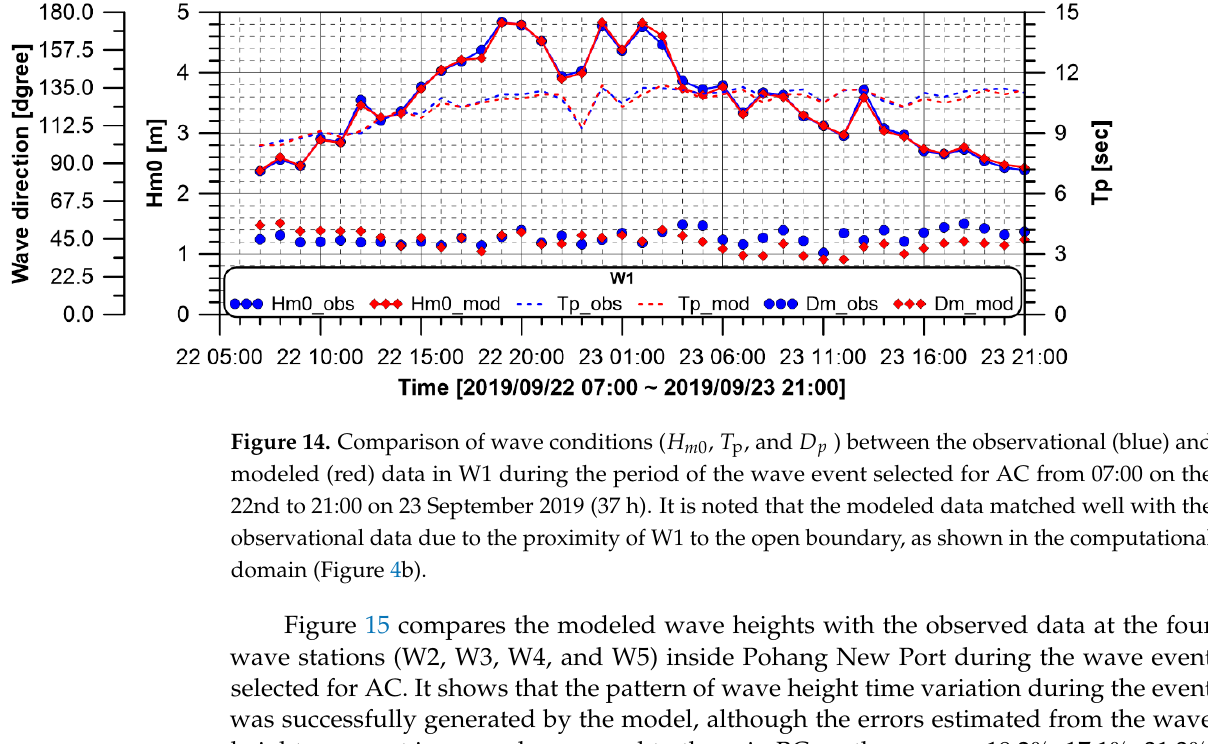
19 of 31 Figure 13. Comparison of wave height ( 𝐻 (cid:3040)(cid:2868) ) between the observational (blue) and modeled (red) data at the four wave stations inside Pohang New Port (W2, W3, W4, and W5) during the period of the wave event selected for BC from 05:30 on the 26 to 21:30 on 27 April 2009. Reasonable agreements are observed between the observational and modeled data, supporting the model validation. A similar comparison between the modeled and observational data was carried out for the selected event case in AC. In Figure 14, the observed and modeled wave conditions in W1 are plotted for the period of the wave event selected for AC, from 07:00 on the 22 to 21:00 on 23 September 2019. Similar to the event case in BC, the wave conditions in W1 were nicely matched between the model and observation due to the proximity of the lo- cation of W1 to the open boundary. It was shown that the wave height increased to be- come the maximum ( 𝐻 (cid:3040)(cid:2868) ~4 .8 m) at 19:00 on 22 September 2019 and then gradually de- creased to ~2.5 m at 21:00 on the 23rd in W1. The wave period generally increased from ~8.5 s to ~11.0 s, and the 𝐷 (cid:3043) value fluctuated between 30 ° and 60 ° , showing that the waves generally approached from NE in W1 during the wave event. Figure 15 compares the modeled wave heights with the observed data at the four wave stations (W2, W3, W4, and W5) inside Pohang New Port during the wave event